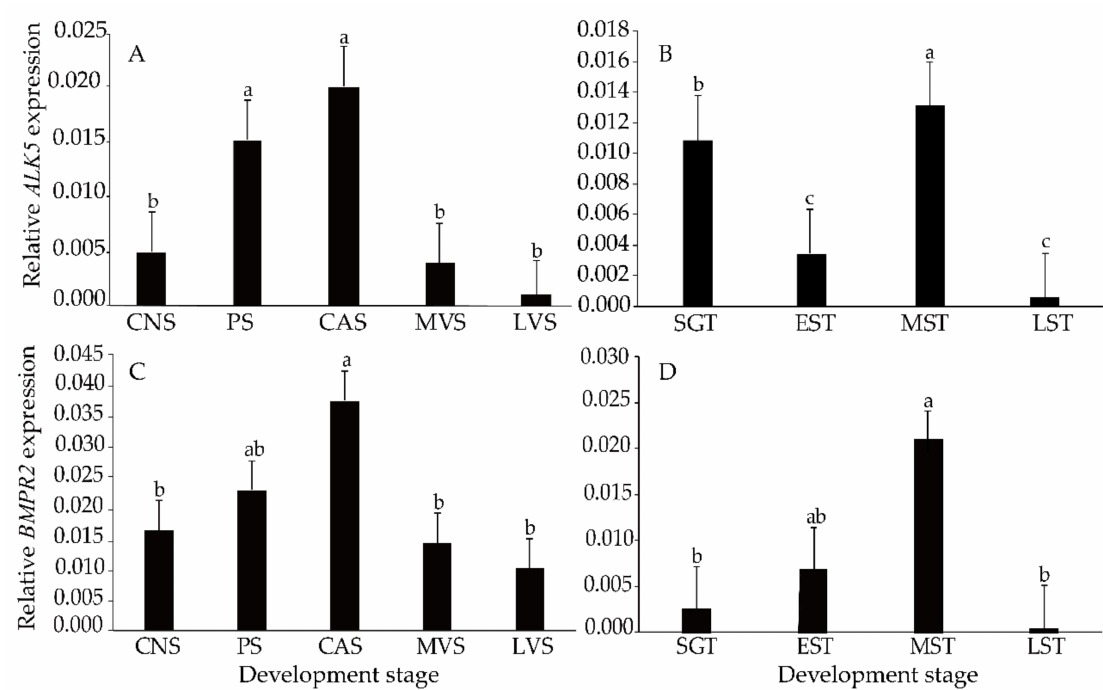
Figure 3. Expression of ALK5 ( A , B ) and BMPR2 ( C , D ) during gonadal development (n = 5). CNS, ovary at the chromatin nucleolar stage; PS, ovary at the perinuclear stage; CAS, ovary at the cortical alveoli stage; MVS, ovary at the mid-vitellogenic stage; LVS, ovary at the late vitellogenic stage; SGT, testis at the spermatogonium stage; EST, testis at the early spermatogenic stage; MST, testos at the mid-spermatogenic stage; LST, testis at the late spermatogenic stage. Means marked with different letters are significantly different ( p <